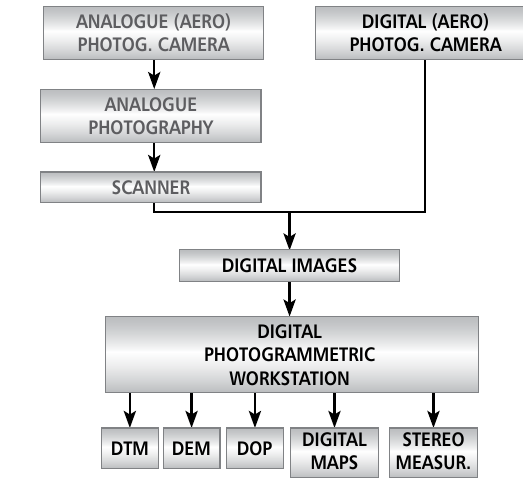
FIGURE 2 The simplified schematic workflow in digital